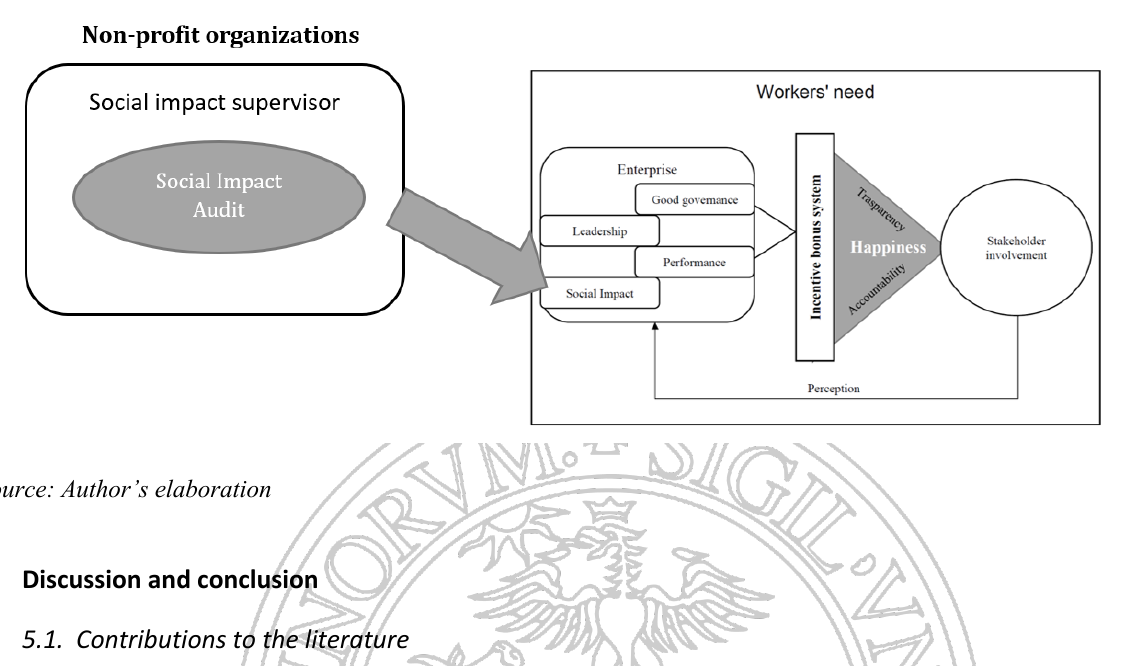
Figure 5. Simplification of